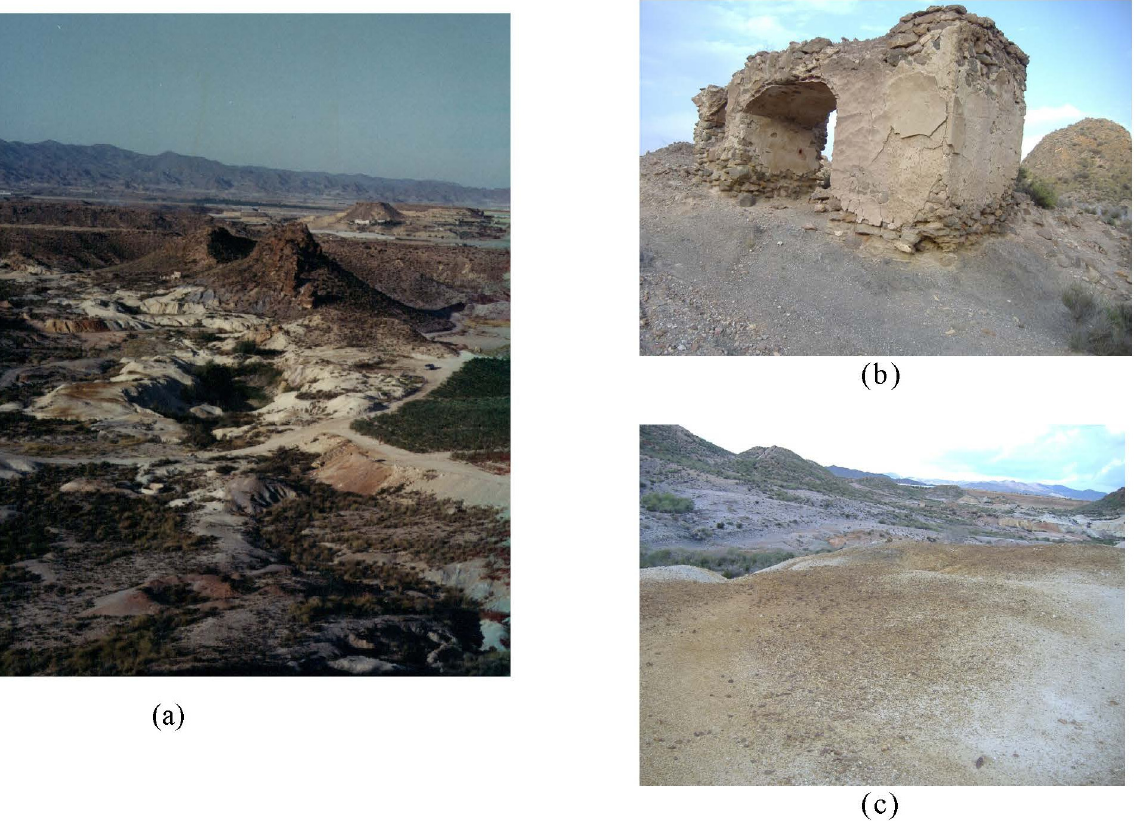
Figure 1. ( a ) General view of Valle del Azogue area. ( b ) Detail of the calcines and old metallurgical plant (location of MA4 and MA5 samples). ( c ) Detail of weathered superficial mine wastes (location of MA1 and MA2